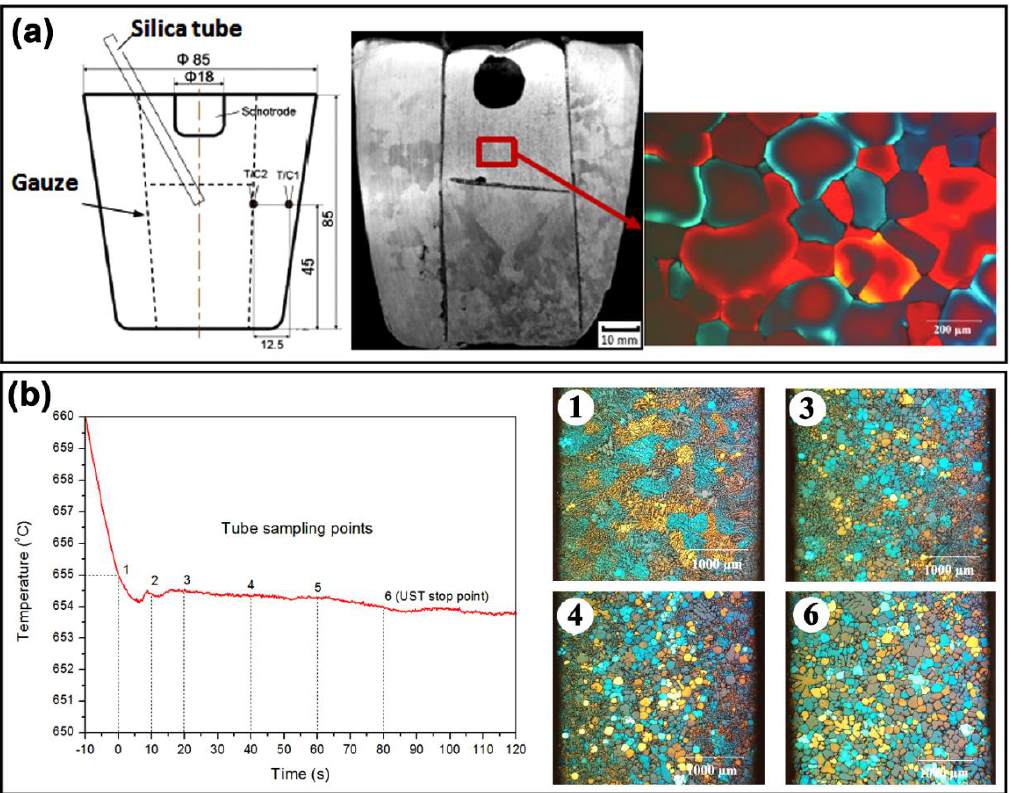
Materials 2019 , 12 , 3187 17 of 33 the equiaxed zone (i) rosette or mixed dendritic grains just above the equiaxed layer and (ii) large columnar grains at the top surface of the casting influenced by the radiation heat transfer [76]. Based on the thermal conductivity of the metal, the action of grains filling the macrostructure of the Al-2Cu alloy ingot (Figure 11a) is faster (80 s) than that of pure Zn (240 s, Figure 11b). Furthermore, it is interesting to note that increasing the time from 20 to 80 s (Al-2Cu alloy) produces completely equiaxed grains throughout the cross section of casting whereas in Zn increasing the time duration from 180 s to 240 s results in a similar area of equiaxed zone. Also, the temperature range at which Figure 10. ( a ) Schematic of the UST setup that uses a stainless-steel mesh to capture the grains beneath excellent refinement is achieved is 40 °C above the liquidus temperature in Al-2Cu alloy and for Zn Figure 10. ( a ) Schematic of the UST setup that uses a stainless-steel mesh to capture the grains beneath the molybdenum sonotrode and the resultant macrostructure and microstructure (taken from the gauze it is 20 °C above the melting temperature. This comparison shows that UST produces similar the molybdenum sonotrode and the resultant macrostructure and microstructure (taken from the tendencies in grain formation and settling regardless of the type of metal and it only depends on the area). ( b ) Cooling curve of Al-2Cu alloy with numbers denoting the time at which tube samples were gauze area). ( b ) Cooling curve of Al-2Cu alloy with numbers denoting the time at which tube samples temperature range of UST. taken during UST and the corresponding microstructures of samples 1, 3, 4 and 6 [76]. were taken during UST and the corresponding microstructures of samples 1, 3, 4 and 6 [76] .